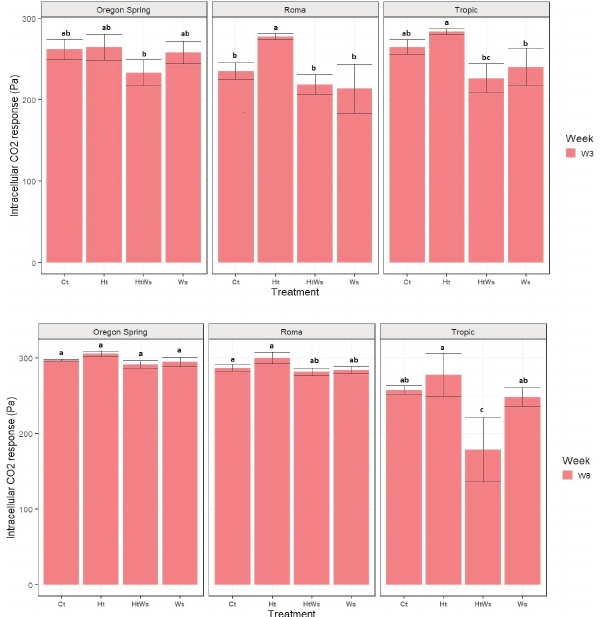
Fig. 2 ­ Intracellular CO response (Pa) of the three tomato varie­ 2 ties (Oregon Spring, Roma and Tropic). The treatments consist of Control (Ct), Water stress (Ws), Heat + Water stress (HtWs) and Heat (Ht). W3 and W8 = weeks of treatments imposition with measurements. Bars with the same letter are not significantly different at P<0.05 according to